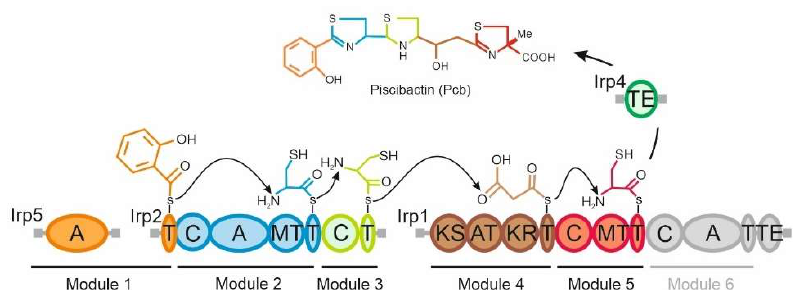
Figure 7. A biosynthetic model for piscibactin assembly showing module organization and pre- dicted substrate of Irp5, Irp2 and Irp1. Conserved domain annotation: A—adenylation, T—aryl or peptidyl carrier protein, C—condensation, MT—methyltransferase, KS—ketoacyl